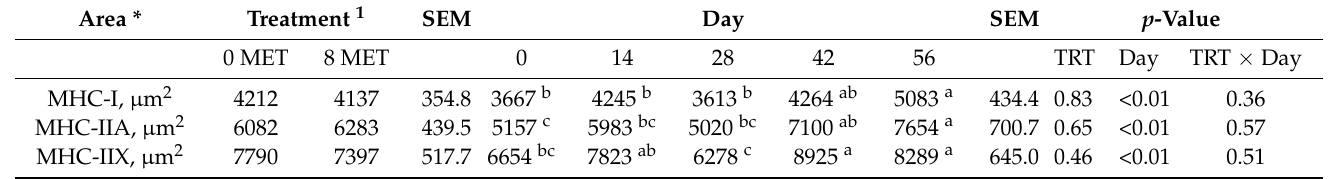
Table 9. Effect of encapsulated amino acids on muscle fiber cross-sectional area in longissimus tissue. Area *